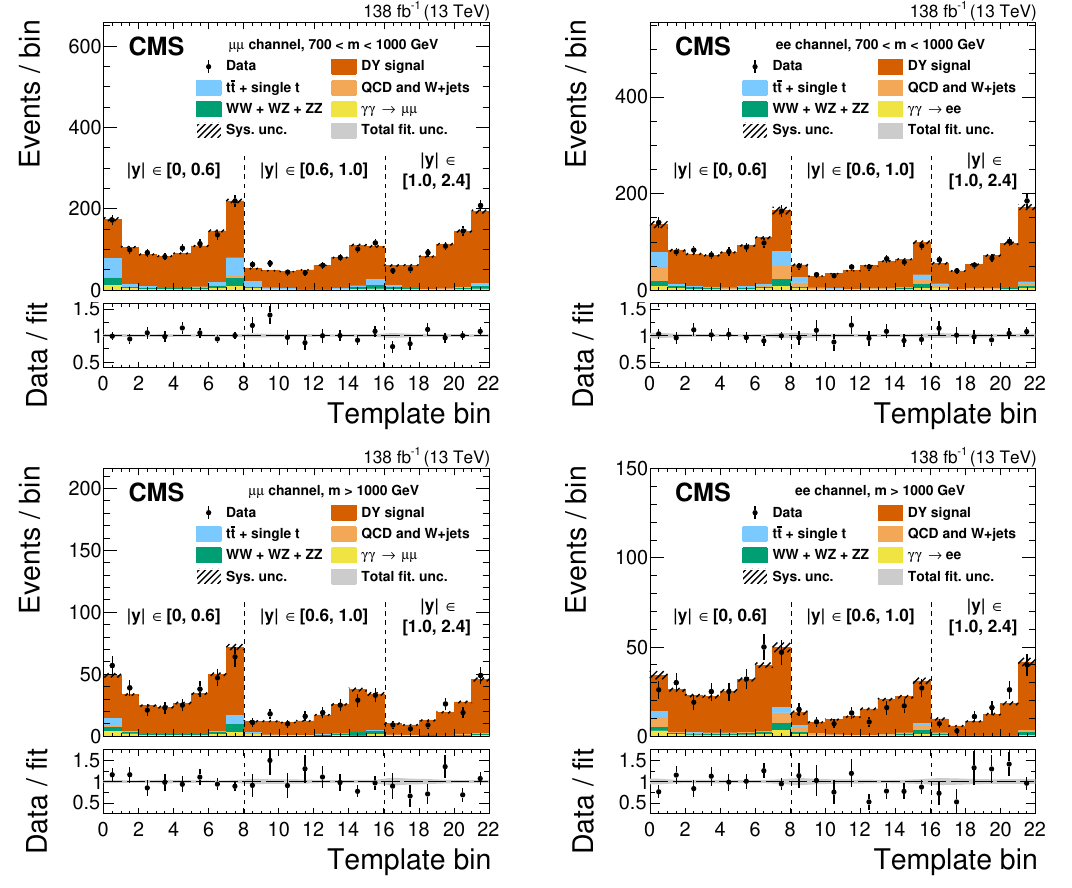
Figure 9 . The postfit distributions in the 700–1000 and > 1000 GeV mass bins are shown in the upper and lower rows, respectively. The left plot is the mm channel, and the right plot the ee channel. The contribution of the tt background is not visible on the scale of these plots and has been omitted. The 2D templates follow the cos θ and | y | binning defined in section 7 but are R presented here in one dimension, with the dotted lines indicating the different | y | bins. The black points and error bars represent the data and their statistical uncertainties. The bottom panel in each figure shows the ratio between the number of events observed in data and the best fit value. The gray shaded region in the bottom panel shows the total uncertainty in the best fit